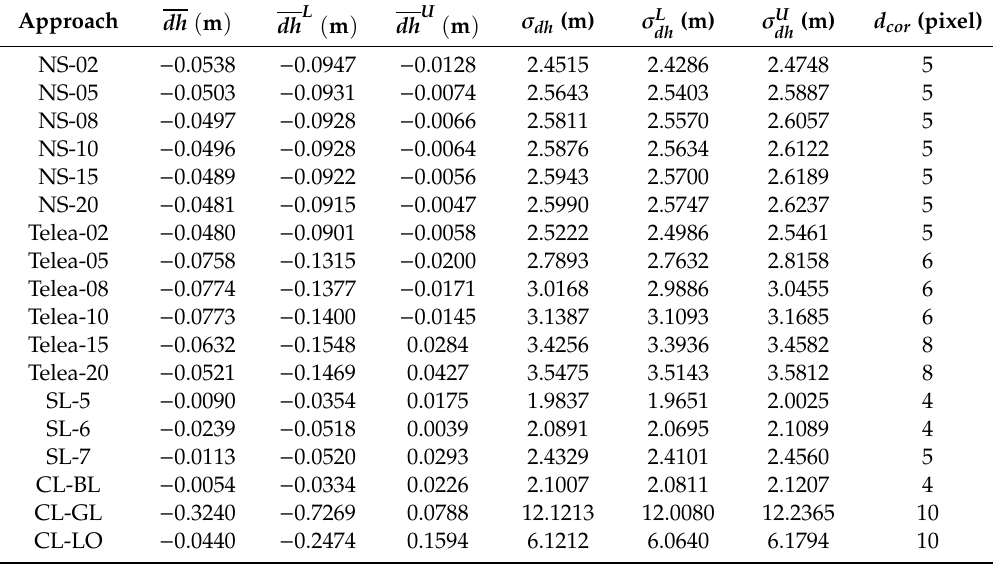
Table 3. Mean dh and standard deviation σ dh of sampled o ff set values for the Correlation setup including L U lower, dh , and upper, dh , bounds of simultaneous 95% confidence intervals. d cor : correlation length of inpainted o ff